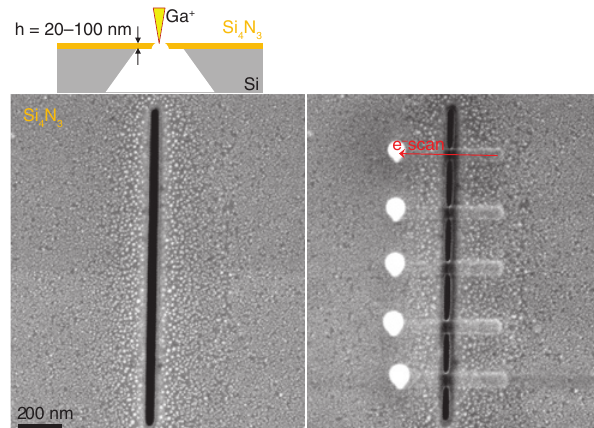
N membrane (left) was patched by 5 keV 3 4